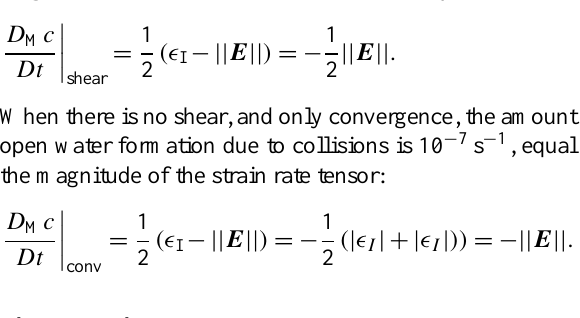
simulates shear of fixed magnitude ( (cid:15) I = 0 ,(cid:15) II = 10 − 7 ) s − 1